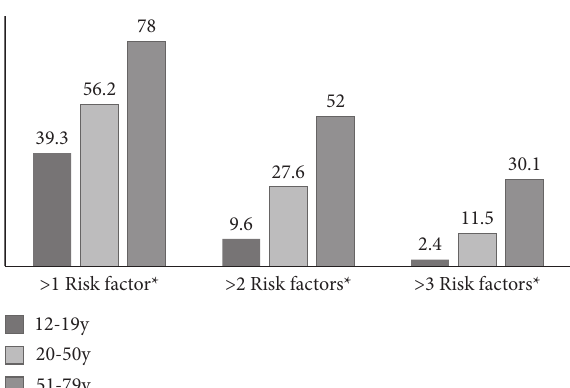
Figure 1: The prevalence of Canadians (12–79y of age) with at least one, two, and three components of metabolic syndrome across the three age groups of 12–19, 20–50, and 51–79 years. Canadian Health Measures Survey combined Cycles 1 and 2, 2007–2011 ( n � 4,272, mal- es � 49.6%, representative of 26,038,108 Canadians aged 12 to 79 years), was conducted. ∗ Significance differences between MetS prevalence of the three age